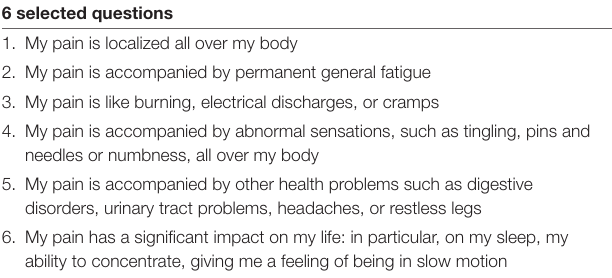
TABLE 2 | FIRST questionnaire to identify fibromyalgia within a